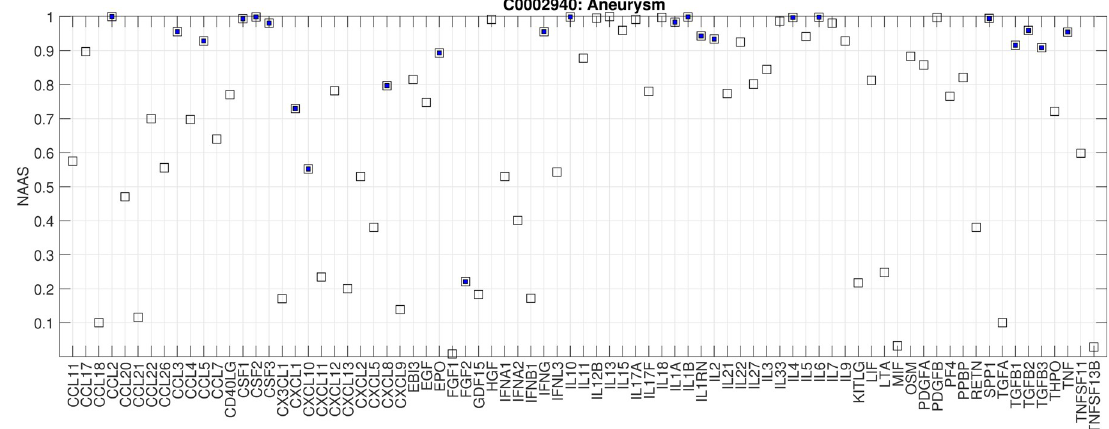
Fig 6. The NAAS between aneurysm and each of the 79 cytokines for which the literature sampling frequency in disease is known in ImmuneXpresso. Known associations (frequency cutoff of 0.005 in ImmuneXpresso) are marked in solid blue squares.